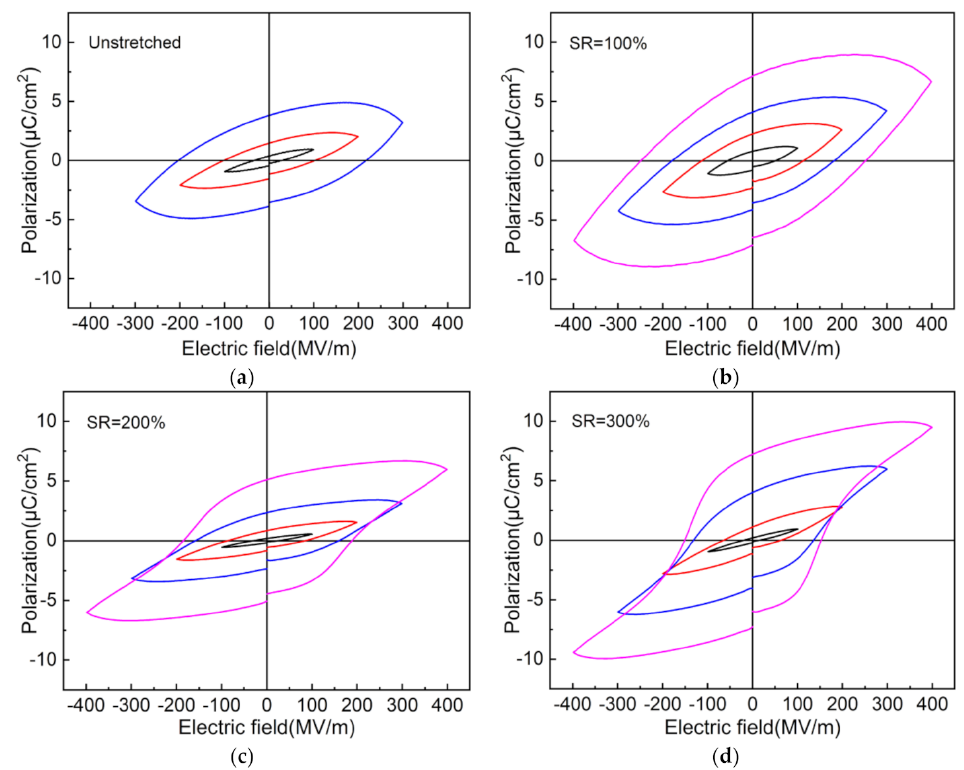
Figure 7. D - E hysteresis loops of the unstretched and stretched nylon-11 films with different stretch- ing ratios (SRs): ( a ) original, ( b ) 100%, ( c ) 200% and ( d ) 300%. The stretching temperature is 80 ◦